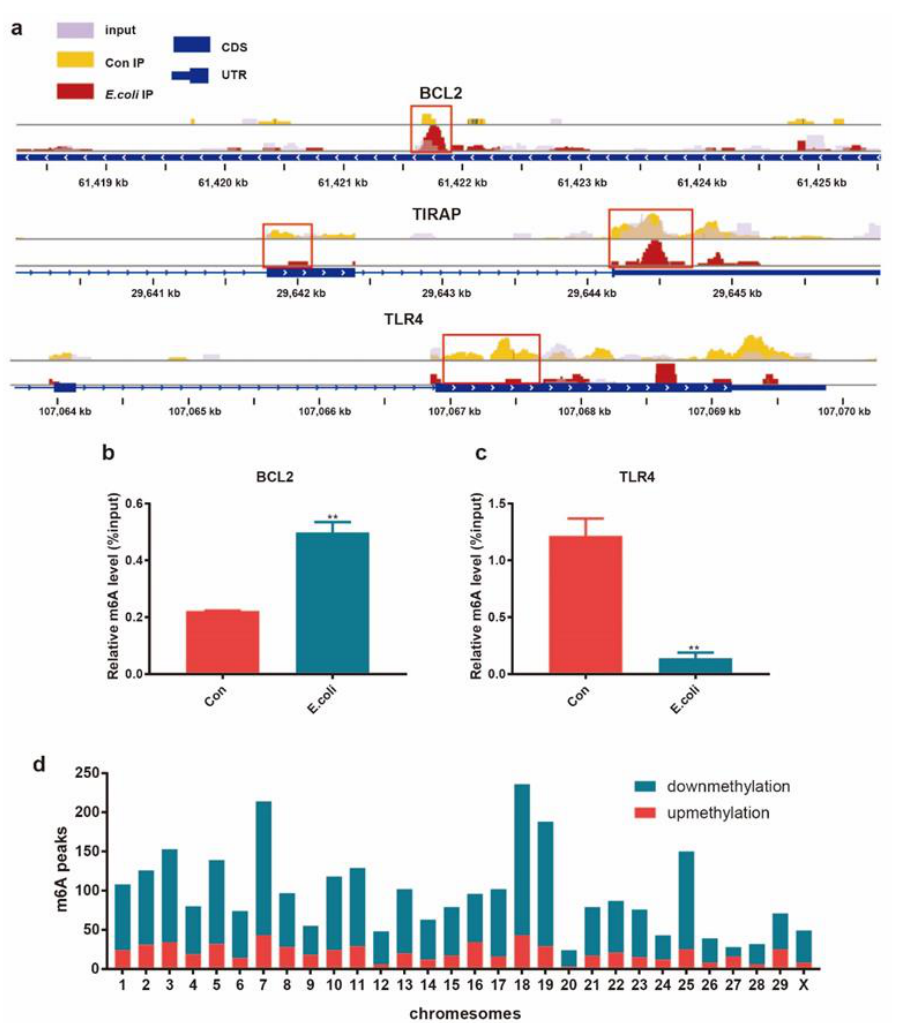
Figure 3. Distribution of significantly differential peaks between the Con and E. coli groups. ( a ) Data visualization analysis of differential m 6 A peaks in selected mRNAs (BCL2, TIRAP, and TLR4) in the E. coli group compared with the Con group. MeRIP-qPCR verified the differential m 6 A modification in BCL2 ( b ) and TLR4 ( c ). ( d ) Distribution of differential m 6 A sites on bovine chromosomes.